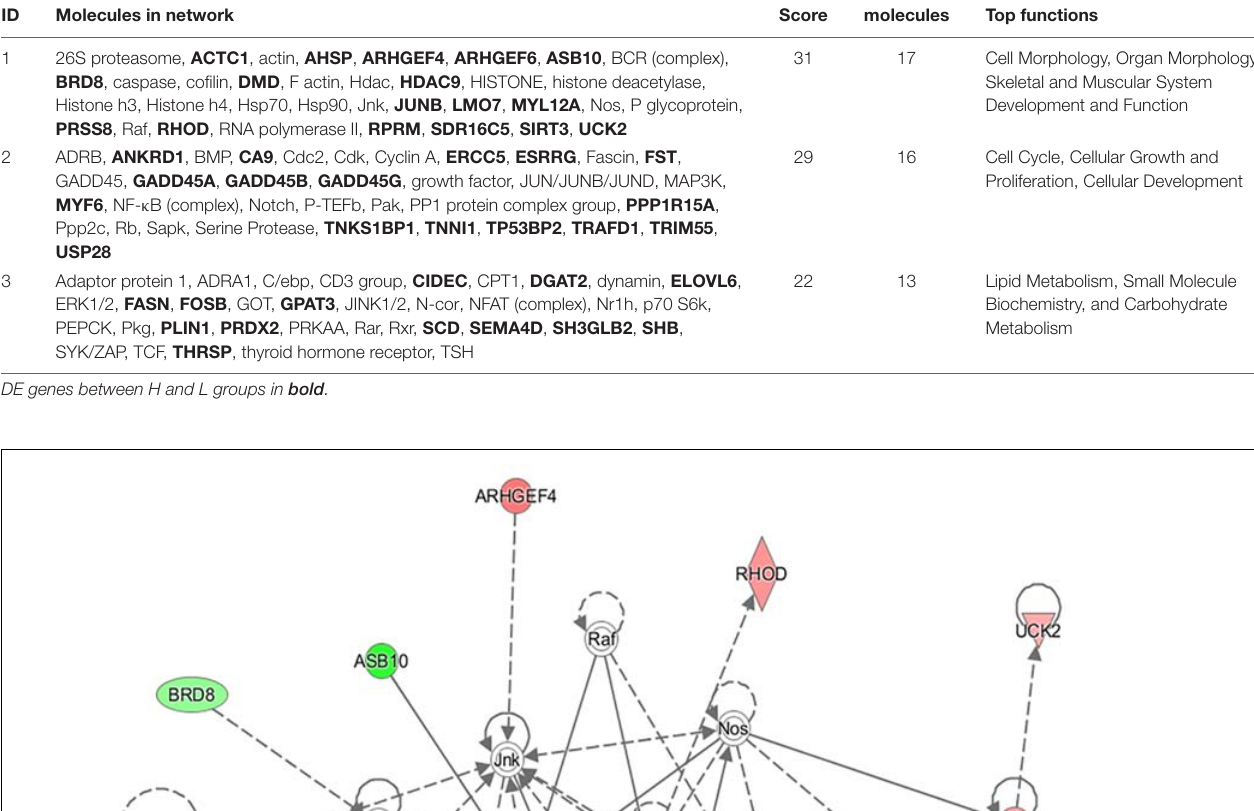
Frontiers in Genetics |